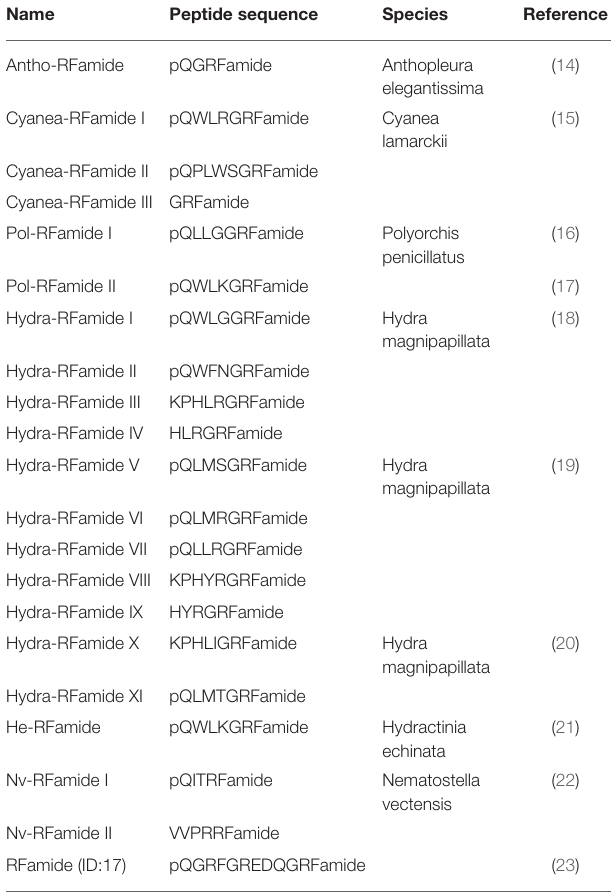
TABLE 1 | FLPs in